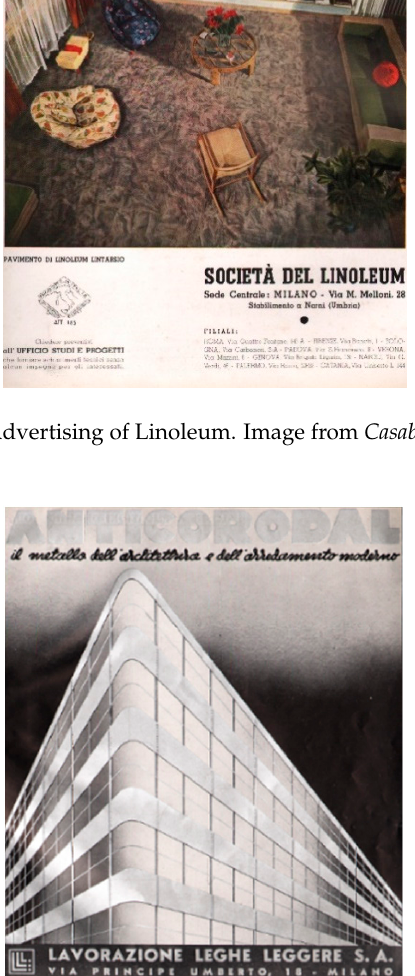
Figure 7. Advertising of Fabbrica Pisana St-Gobain. Image from Civiltà (1940).